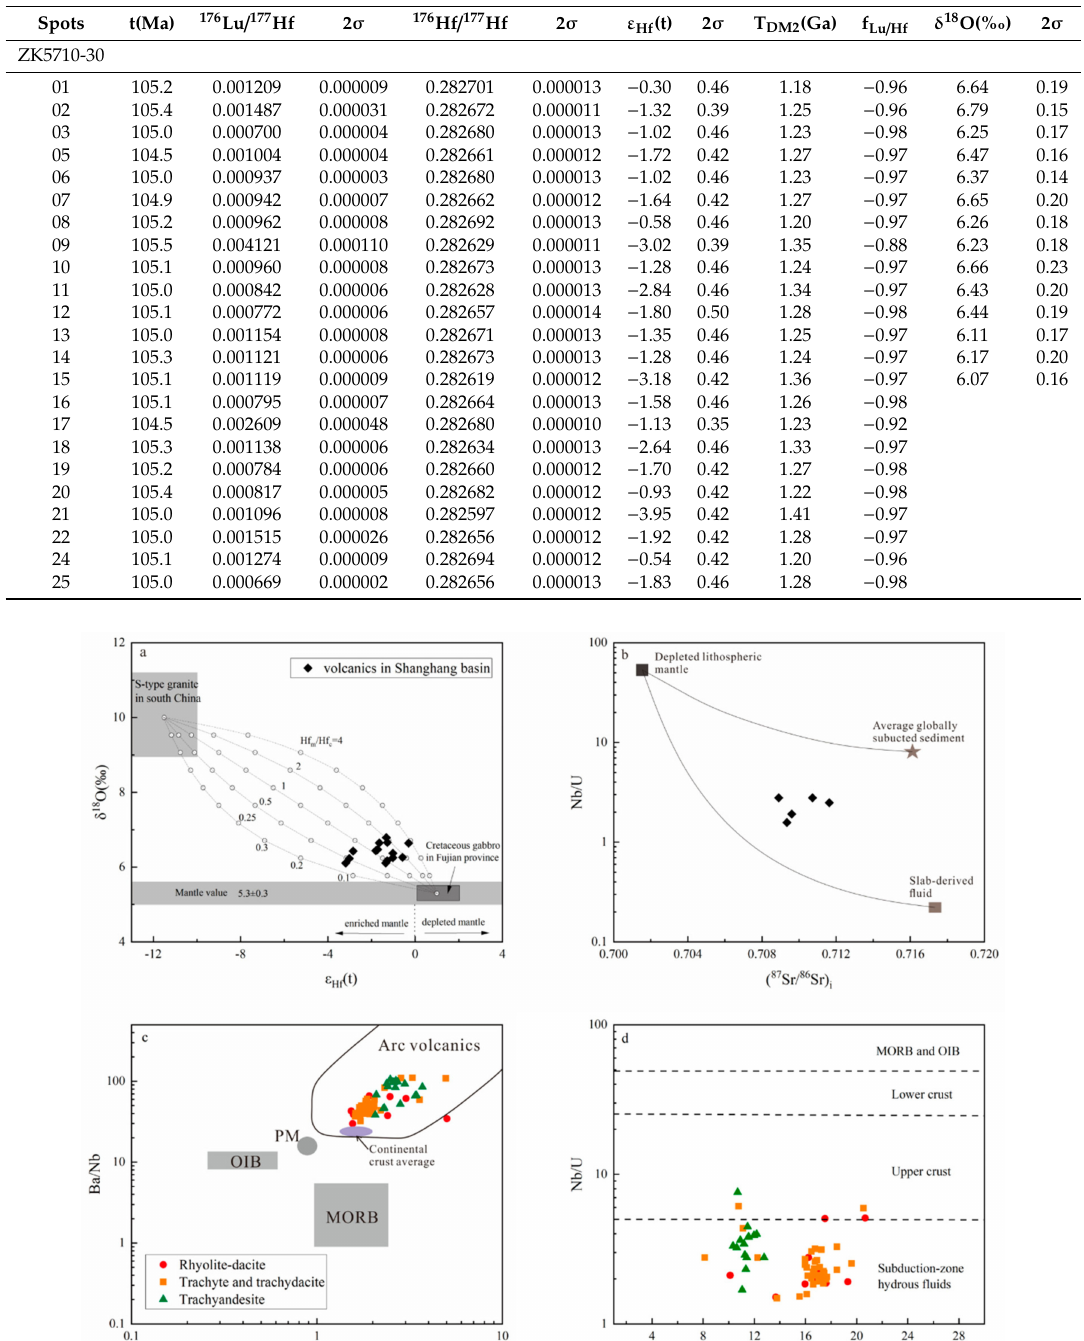
Table 2. Hf-O isotopic data for the volcanic rocks from the Zijinshan ore district. Spots